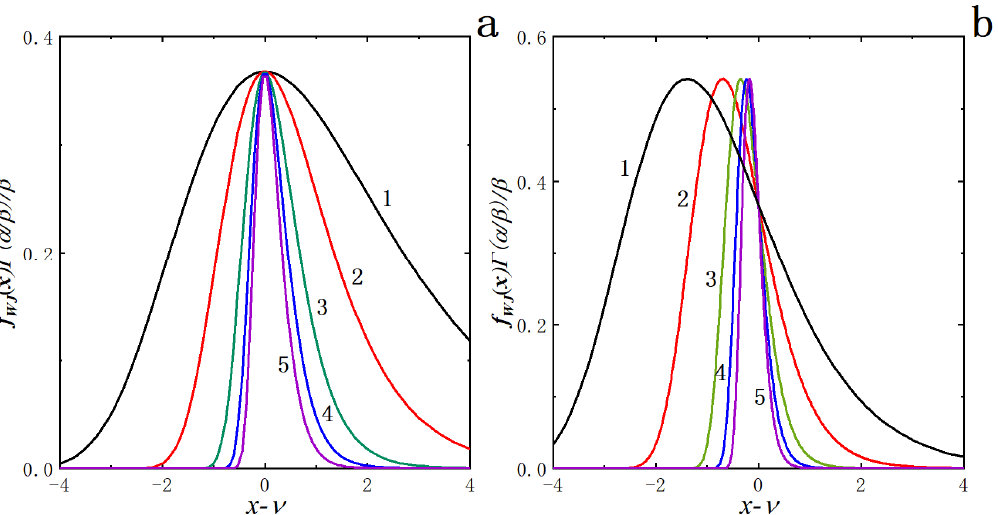
Figure 1. Effects of the parameters α and β on the behavior of the WJ distribution. ( a ) Curves 1~5 in order correspond to α ∈ (0.5, 1, 2, 3, 4) for α / β = 1; ( b ) Curves 1~5 in order correspond to β ∈ (0.5, 1, 2, 3, 4) for α / β = 2.